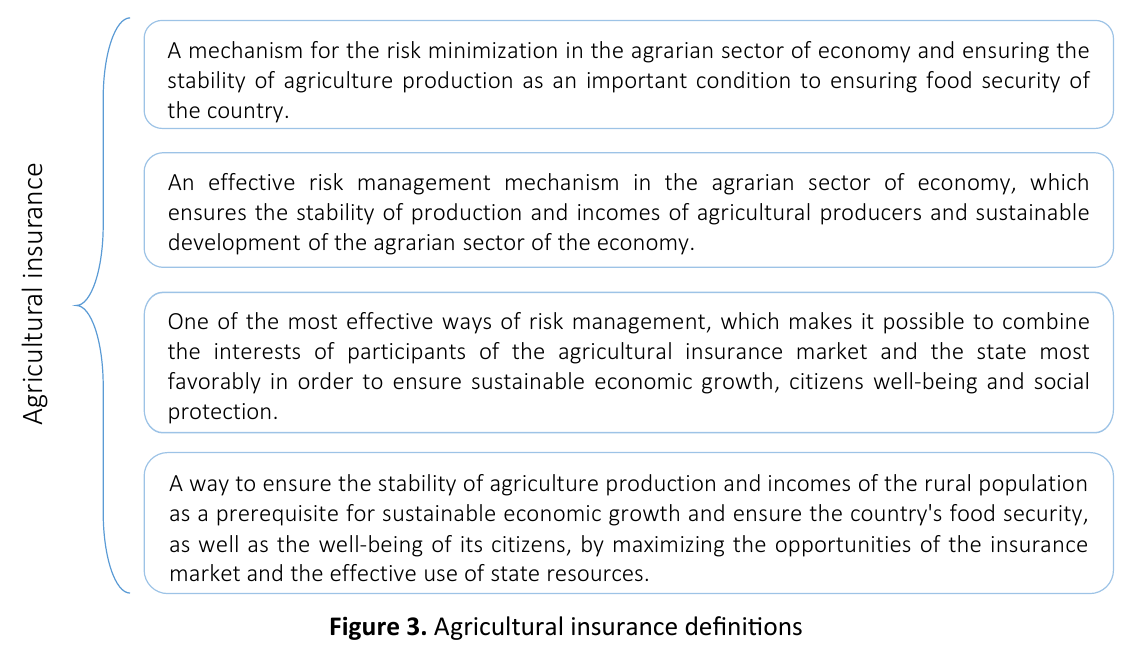
Figure 3. Agricultural insurance